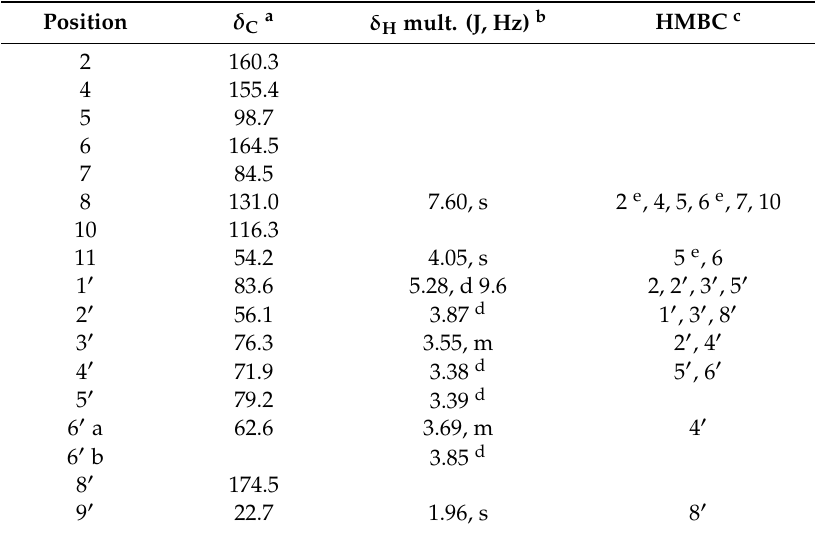
Table 1. Nuclear magnetic resonance spectroscopy data of huimycin.